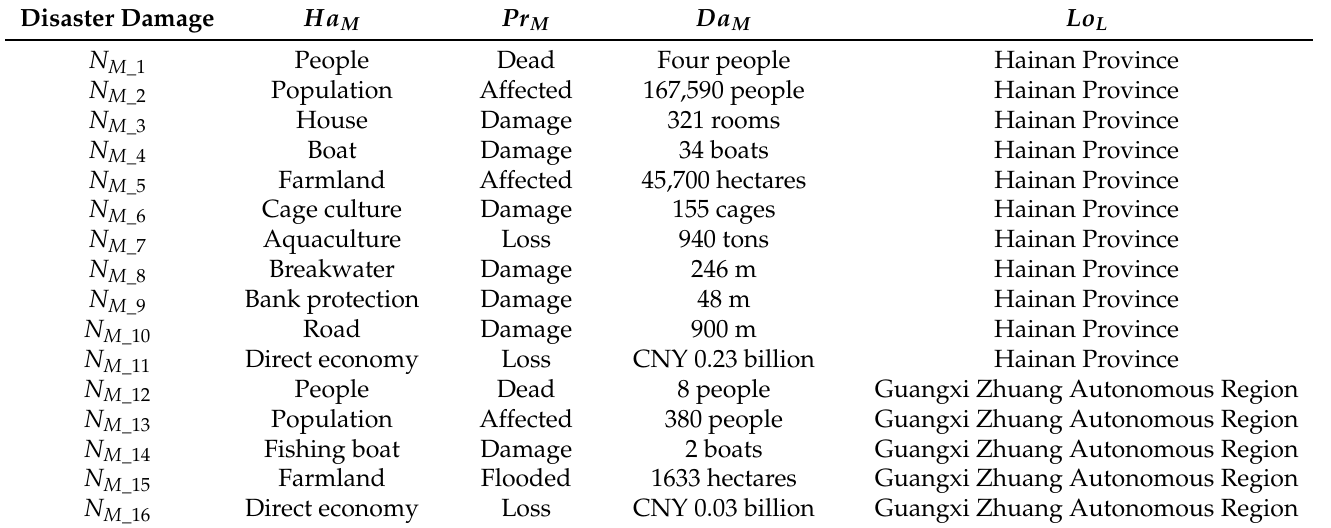
Table 10. Label information V M and V L of storm surge disaster case no.